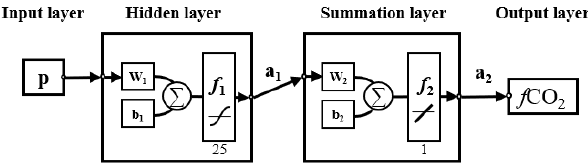
Figure 1. Structure of the feed-forward neural